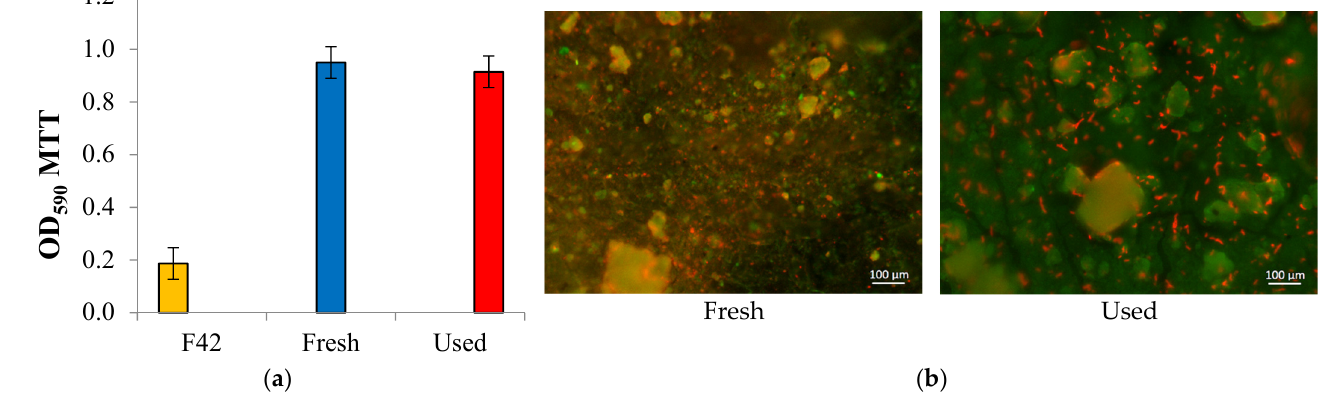
Figure 5. Properties of the created receptor element: ( a )—respiratory MTT assay; ( b )—Images of the surface (1200×) of a freshly prepared sensor with applied Saccharomyces cerevisiae yeast and a sample after a working day. Fluorescent staining: the cells are shown in red, and the polysaccharide biofilm matrix is indicated in green.